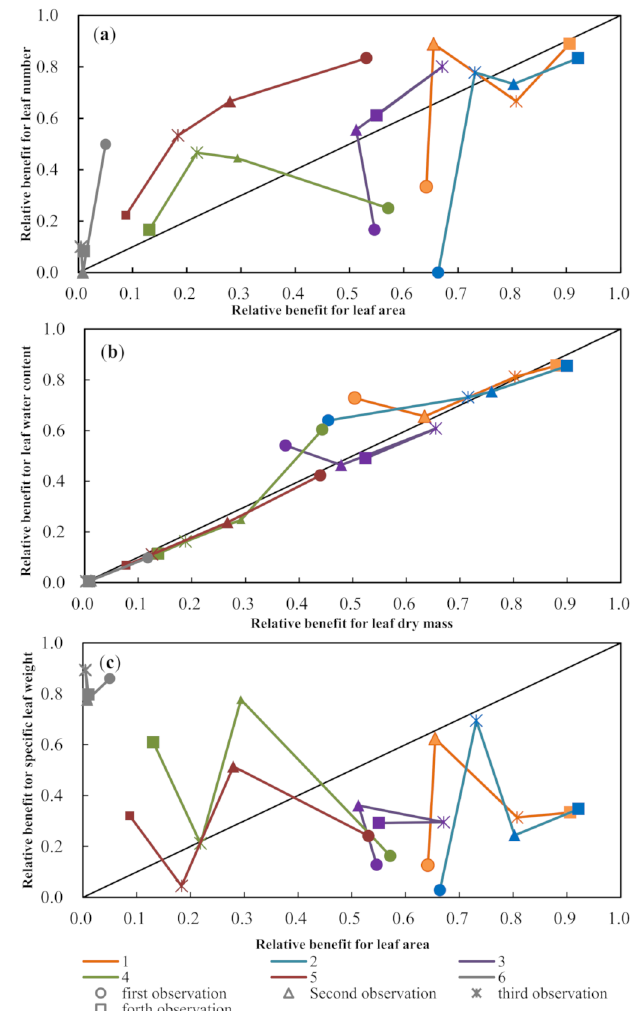
Figure 3. Trade-off between leaf traits of each observation. ( a ) The trade–off between leaf area and leaf number; ( b ) The trade–off between leaf water content and leaf dry mass; ( c ) The trade–off between leaf dry mass and leaf area. The numbers in the legend represent the corresponding treatments, and the different icons refer to different time observations (10 July, 18 July, 31 July and 7 August, respectively). The relative position of the benefit value relative to the diagonal indicates the tendency of the trade-off, the greater the distance to the diagonal, the greater the